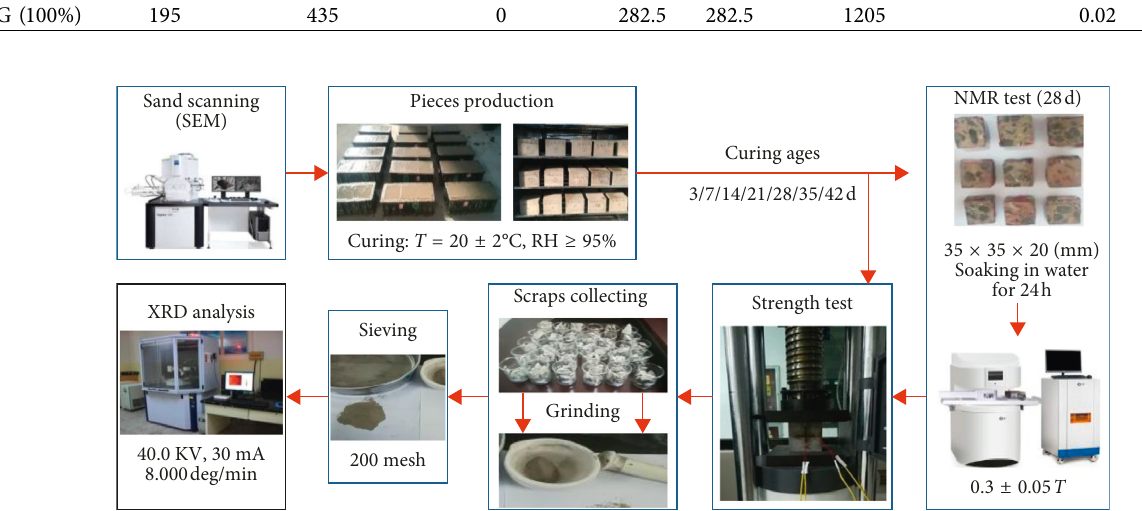
Figure 2: Main test flow chart.